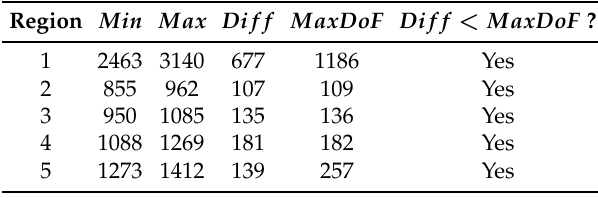
Table 2. Depth values (in mm) of segmented regions in Figure